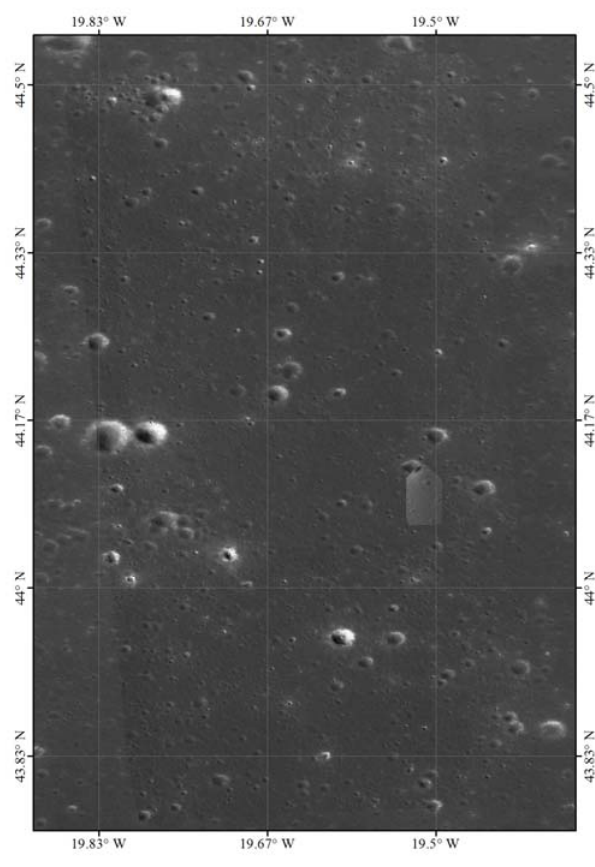
Figure 8. A unified, integrated map at the CE-3 landing